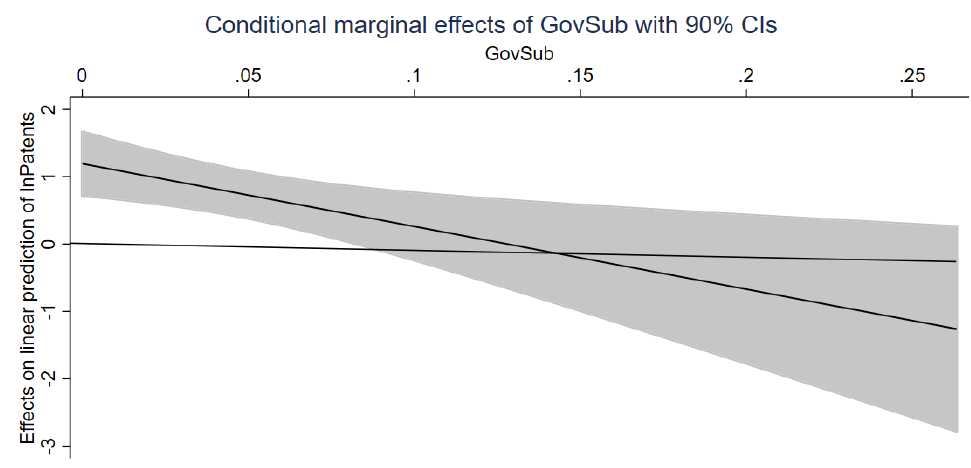
Figure 9. The marginal effect of government subsidies. Note: GovSub and the effects of lnPatents on linear pred. are dimensional parameters. Source: Produced by the authors from the sample data using Stata 16.1.